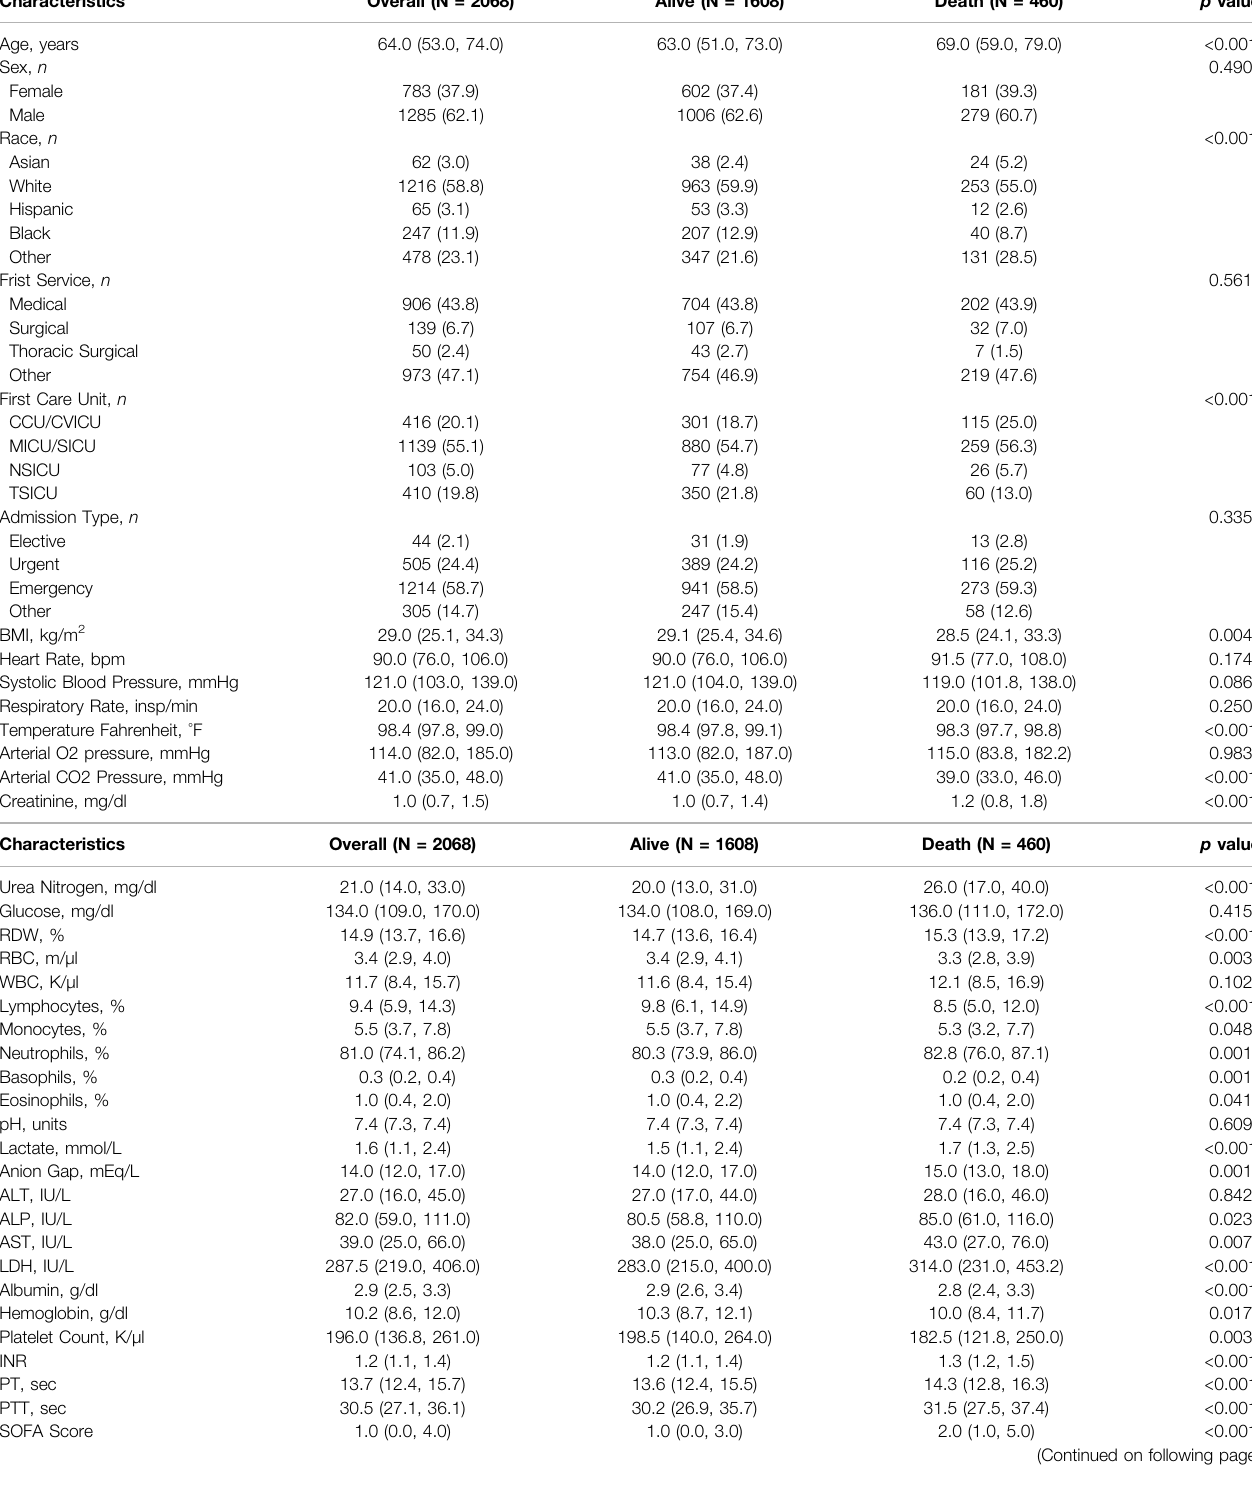
TABLE 1 | Basic characteristics of patients with